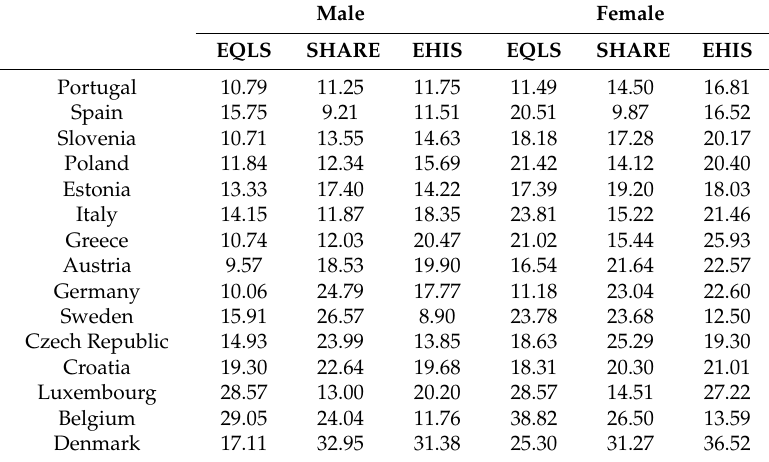
Table 3. Informal Caregivers over 50, by gender (weighted).